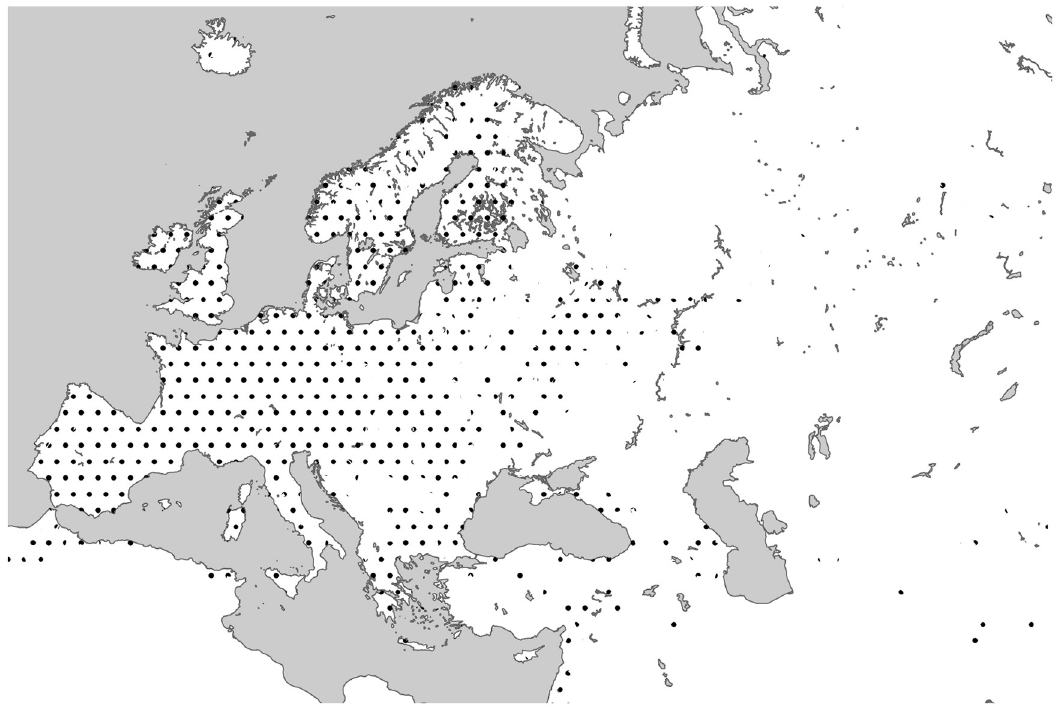
Fig 1. Present-day distribution of perennial ryegrass ( Lolium perenne ). (Data from GBIF.org, https://doi.org/10.15468/dl.4tsemc, visited 7 May 2021).